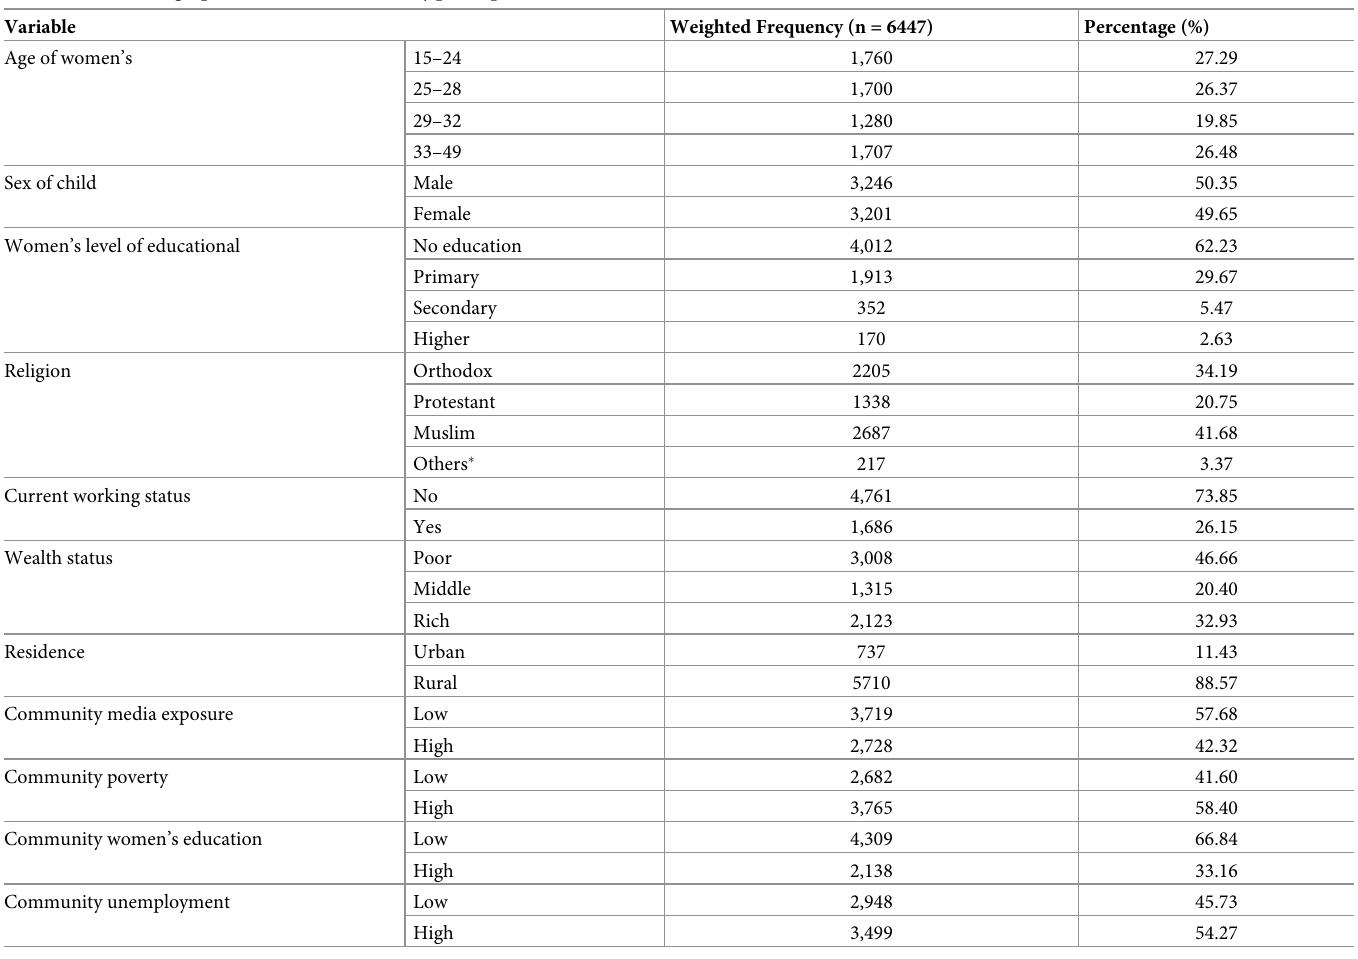
Table 2. Socio demographic characteristics of study